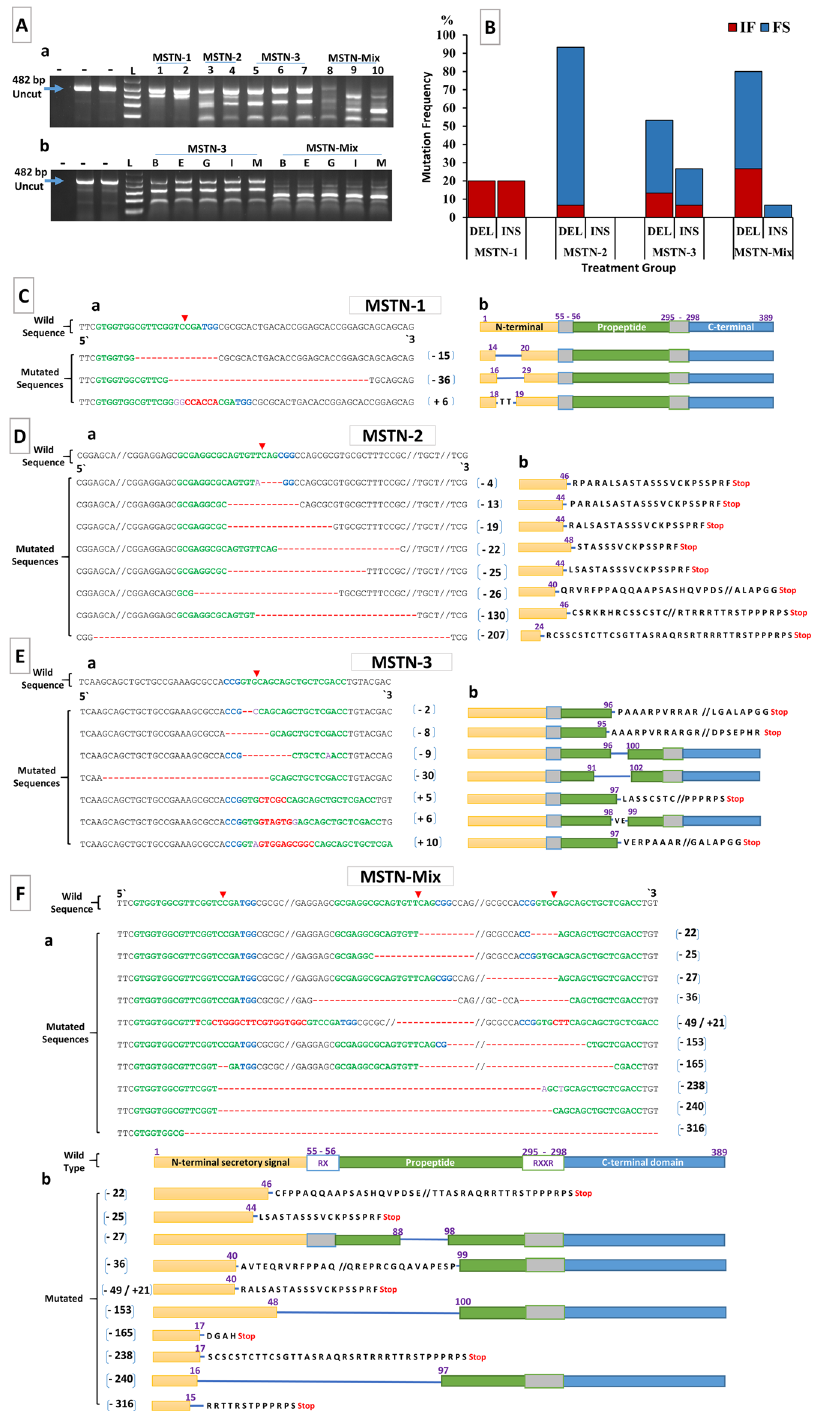
Figure 3. Analysis of mutagenesis efficiencies of CRISPR/ Cas9. ( A ) Identification of edited myostatin (MSTN) gene sequences in channel catfish using the surveyor mutation detection assay. Minus sign indicates the negative control without template [first lane] and the control with wild-type DNA as template [2 nd and 3 rd lanes] (482 bp). L indicates 1 kb plus DNA ladder (Invitrogen, Carlsbad, CA). (a) surveyor mutation detection of MSTN gene in fin-clip samples from 10 individuals from different treatments. Two or more bands indicate that mutations occurred ( < 482 bp). (b) surveyor mutation detection of MSTN gene in different tissues from two mutated channel catfish: B Barbel; E Eye; G Gills; I Intestine; M Muscle. Electrophoretic results were cropped from the original images shown in Supplementary Fig. S1. ( B ) Insertion (INS) and deletion (DEL) mutation frequencies in the treatment groups with in-frame (IF) and frame-shift (FS) mutation percentages. ( C–F ) CRISPR-Cas9-induced mutagenesis efficiencies for the MSTN gene in different treatment groups; ( C ) MSTN-1 ( D ) MSTN-2 ( E ) MSTN-3 ( F ) MSTN-Mix. (a) Sequences of channel catfish MSTN gene